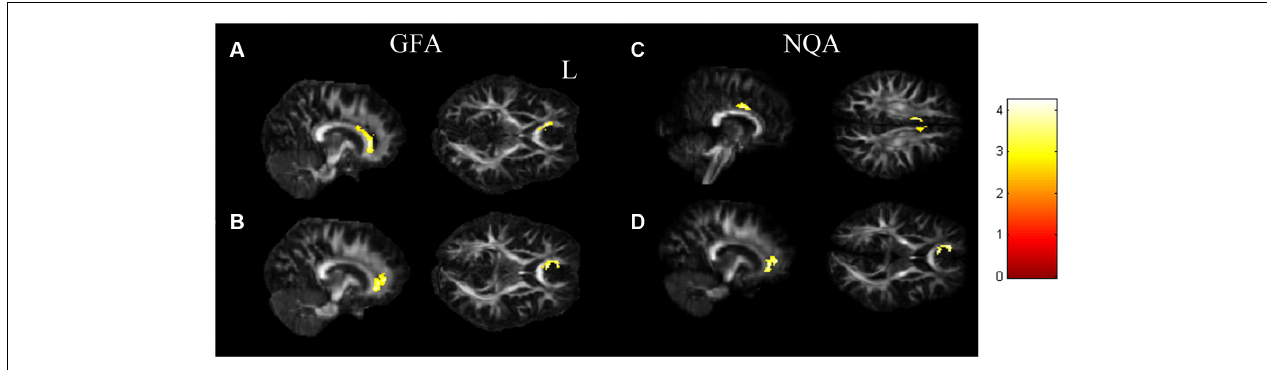
FIGURE 2 | The t -test results. (A) The SI + group showed significantly lower GFA values in the corpus callosum, anterior cingulate than the HC group. (B) Compared to the Depressed group, the SI + group showed significantly lower GFA in the corpus callosum, anterior cingulate. (C) The SI + group demonstrated notably lower NQA values in the anterior cingulate than the HC group. (D) Compared to the Depressed group, the SI + group demonstrated notably lower NQA in the corpus callosum, anterior cingulate ( p < 0.05, cluster size > 100, color bar: t scores).